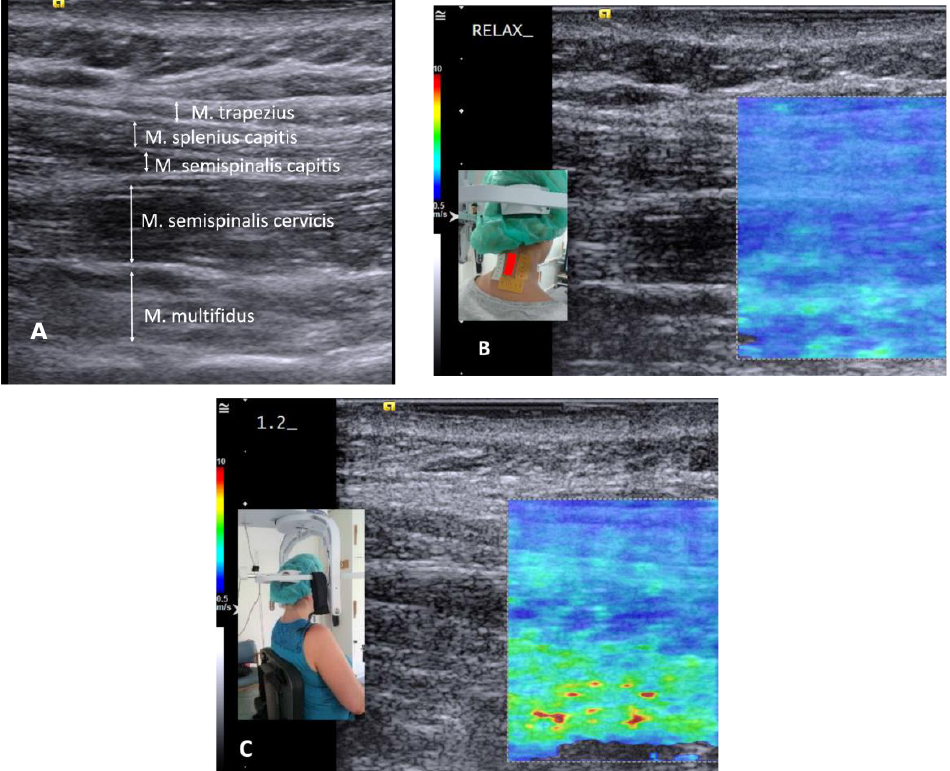
Figure 1. Example images of a control subject: ( A ) neck extensor muscles in ultrasound B-mode; elastogram of the neck muscles during ( B ) relaxed sitting (low stiffness in blue) and ( C ) isometric neck extension at 12 N (high stiffness in red). ( B ) includes a photograph with the transducer location (red) framed with adhesive foam to facilitate repeatability; ( C ) shows setup of the graded force task.